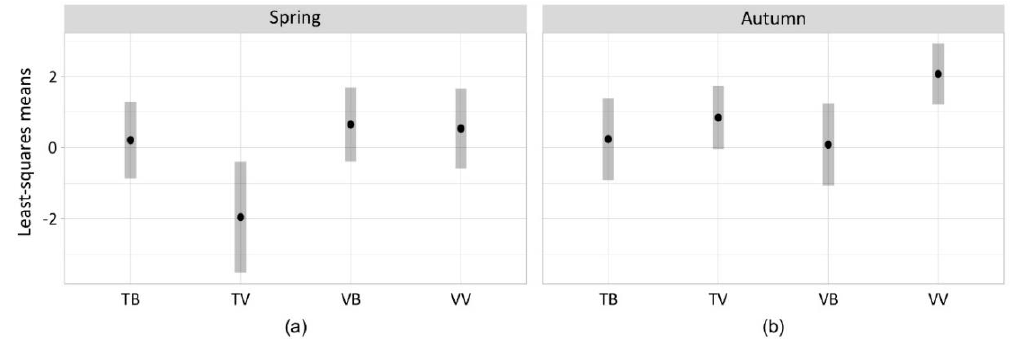
Figure 3. Least-squares means of V. velutina catches (log scale) in spring ( a ) and autumn ( b ) for each combination of trap and bait, derived from the zero-inflated GLMM of Table 2.